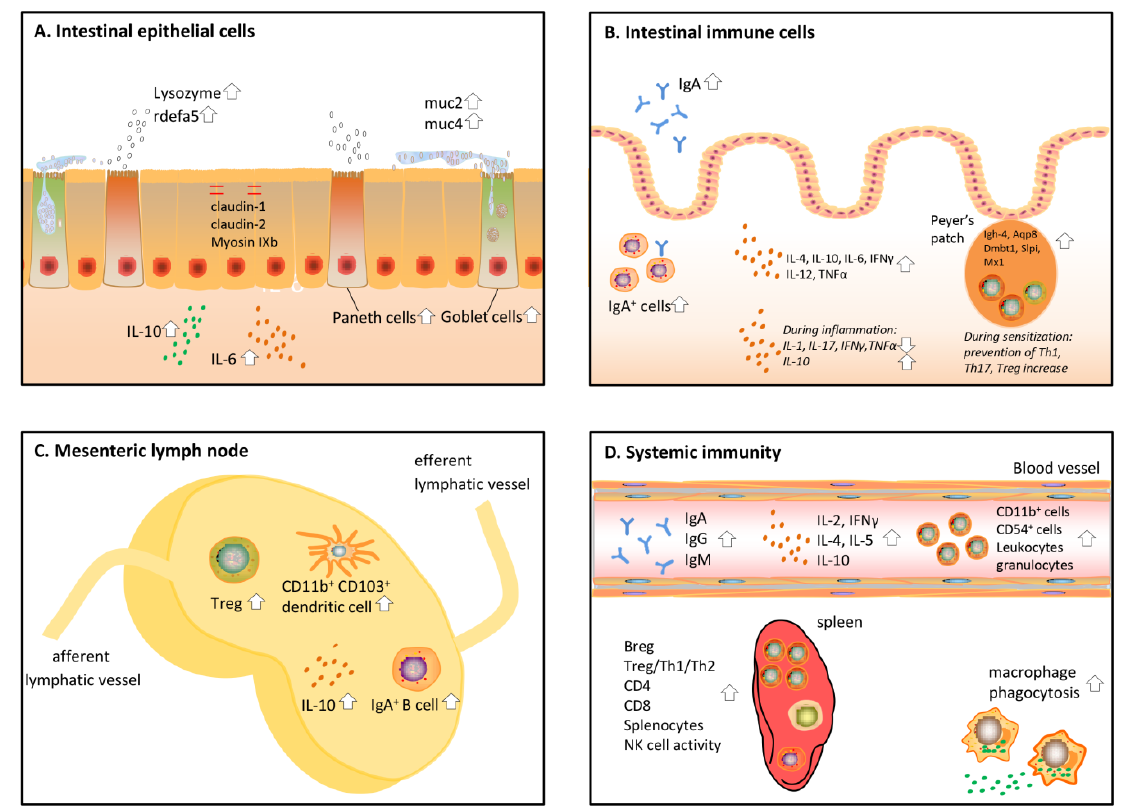
Figure 2. Overview of immune effects induced by protein hydrolysates on the ( A ) intestinal epithelial cells; ( B ) intestinal immune cells; ( C ) mesenteric lymph nodes; ( D ) systemic immune system.